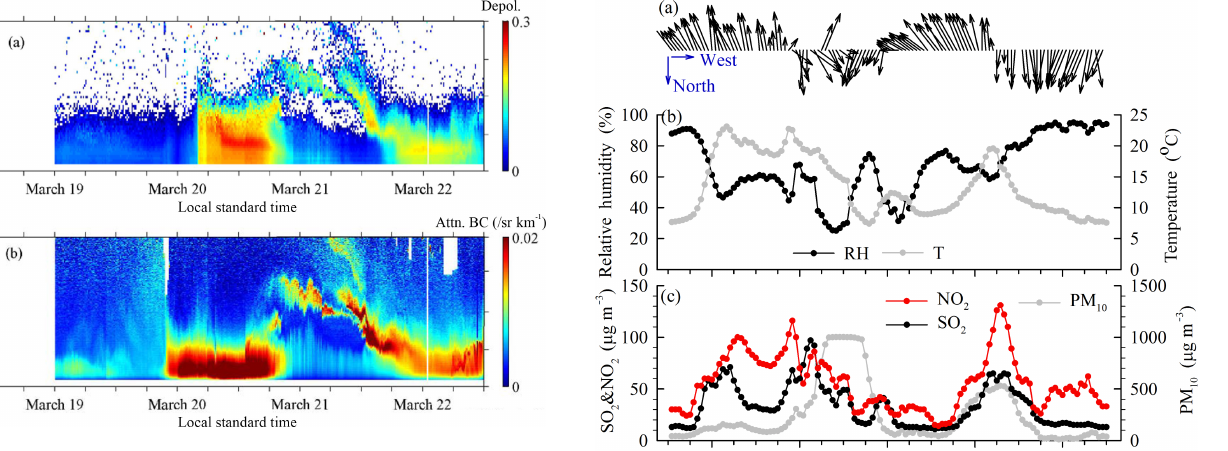
Figure 3. Time–height cross section of (a) volume depolarization ratios and (b) attenuated aerosol backscattering coefficients mea- sured with lidar at the wavelength of 532nm during 19–22 March 2010 (local standard time). Figure 4. Time series of PM 10 , SO 2 , NO 2 , and meteorological fac- tors including wind conditions, relative humidity (RH), and ambient temperature ( T ) in Shanghai during 19–23 March